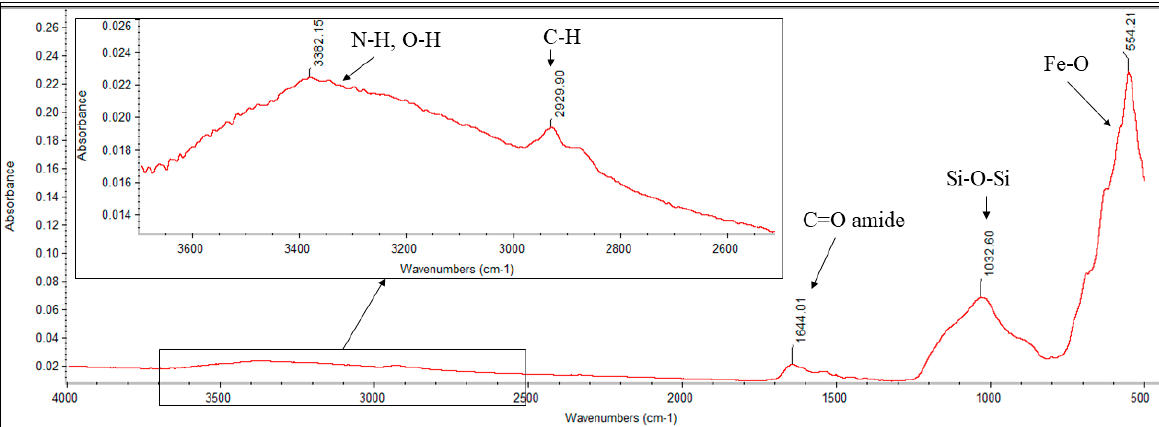
Figure 7. FT-IR spectrum for MW-NPS-1-APS-HMBA.